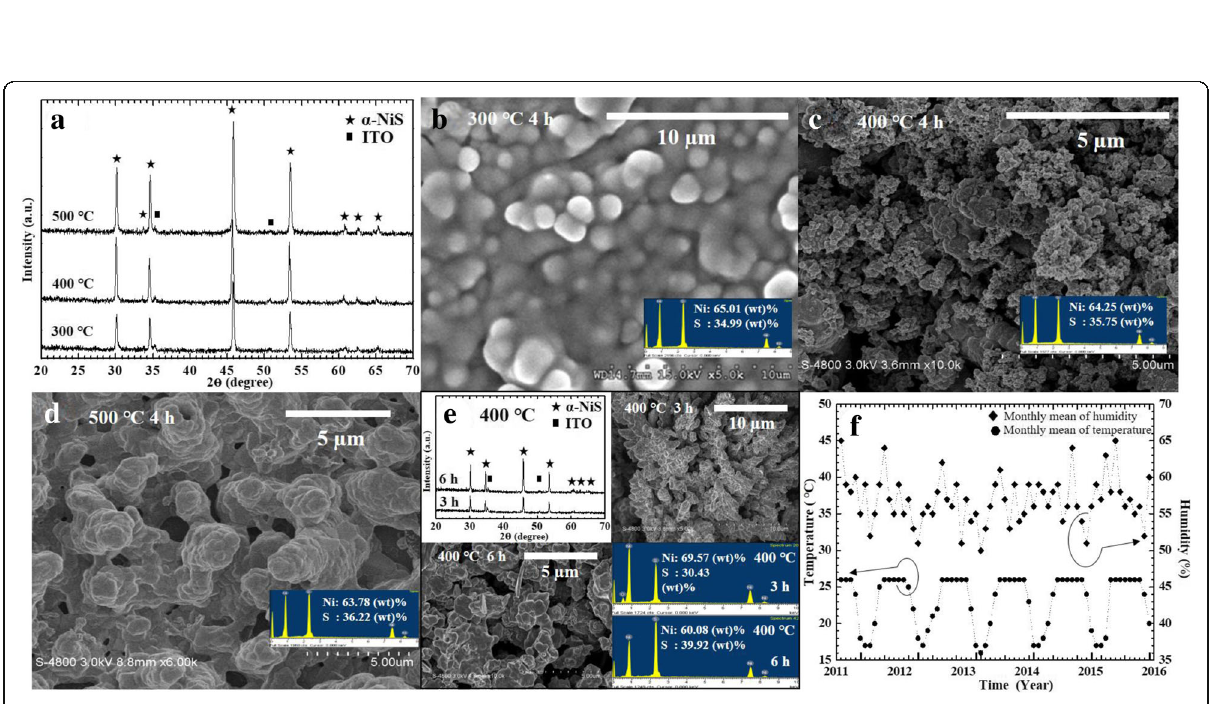
Fig. 2 a XRD pattern shows the α -NiS nanosphere films at different annealing temperatures (300, 400, and 500 °C). The top view images of the α -NiS films were annealed at b 300, c 400, and d 500 °C for 4 h. Inset: the EDS spectra were in the inset of b – d . e The images showed that XRD patterns (top left), FE-SEM images (top right, 3 h; bottom left, 6 h), and EDS spectra (bottom right) of the α -NiS films at different annealing times (3 and 6 h). f The curves showed the record about temperature and humidity measurements in our laboratory for preservation testing of conditions